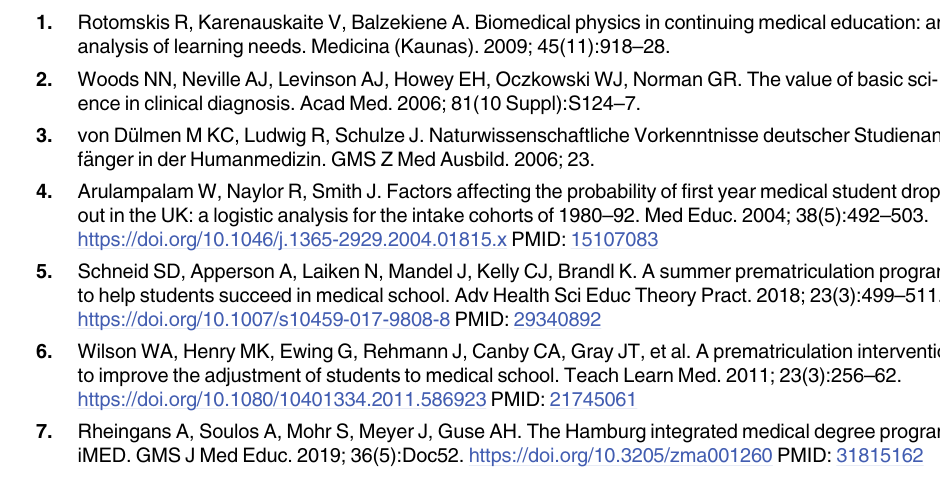
S1 Table. Satisfaction in all physics integrated supportive science courses since 2013.